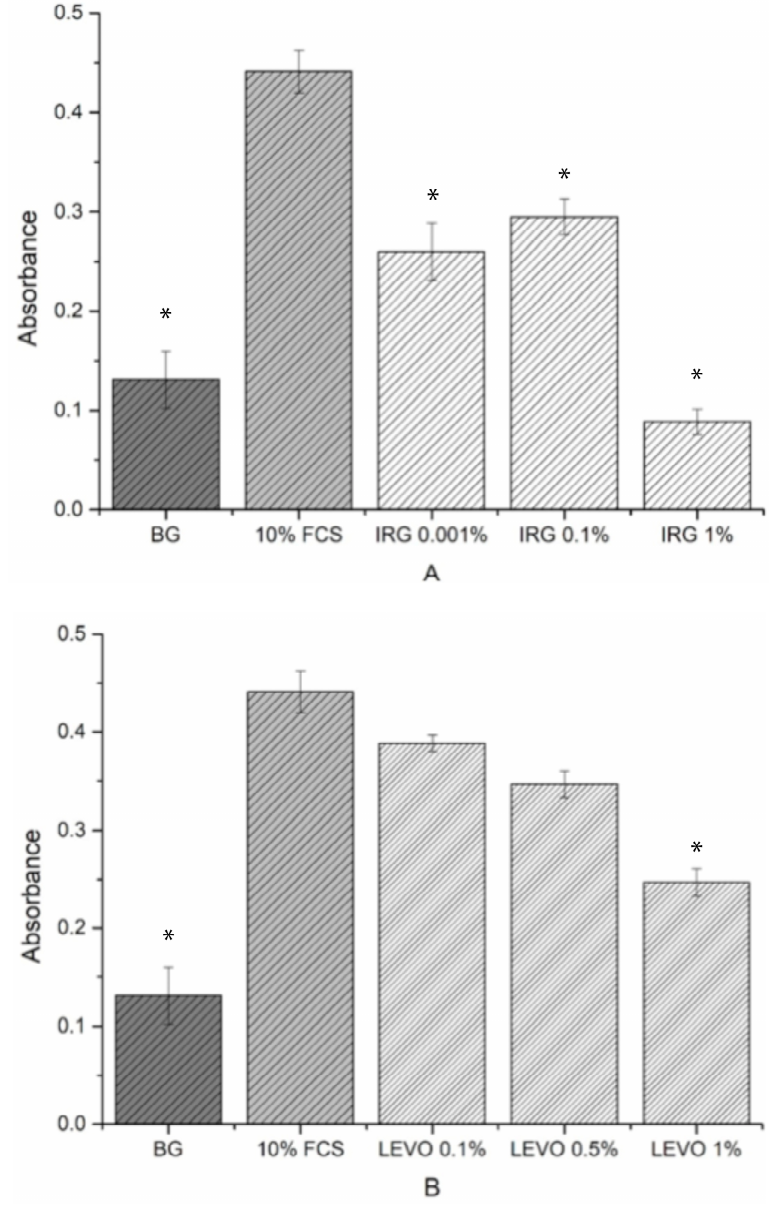
Figure 8. Absorbance data with standard error bars (n = 3) for 5-bromo-2’-deoxyuridine (BrdU) assay against ( A ) background, 10% FCS, 0.01% IRG, 0.1% IRG, 1% IRG. BG, IRG (0.001%), IRG (0.1%), IRG (1%) vs. 10% FCS * p < 0.05. ( B ) background, 10% FCS, 0.1% LEVO, 0.5% LEVO and 1% LEVO concentrations. BG, LEVO (0.1%), LEVO (0.5%), LEVO (1%) vs. 10% FCS * p < 0.05.